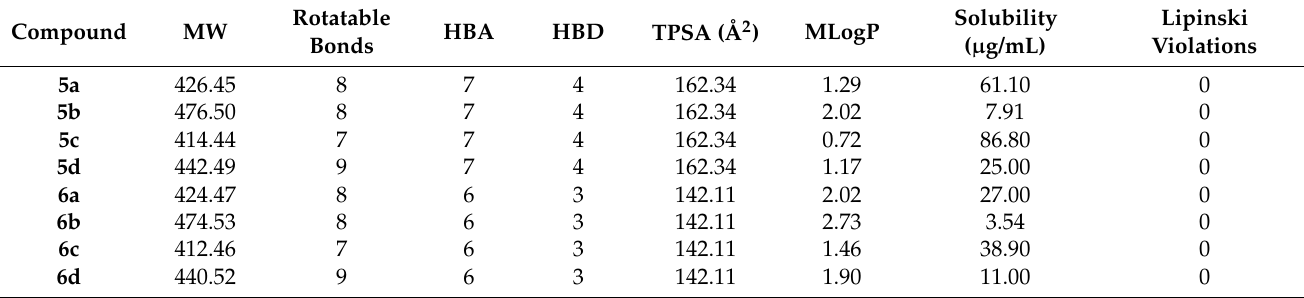
Table 10. Molecular properties of the compounds 5a – d and 6a – d with strong influence on their